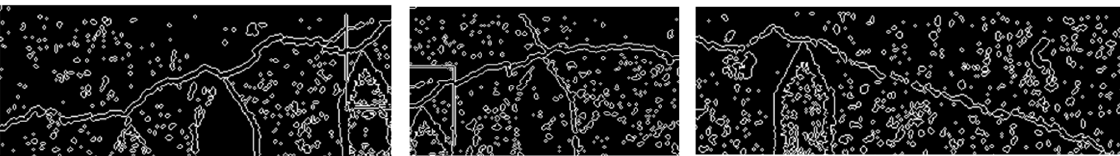
Figure 19. Morphological edge detection outcome.